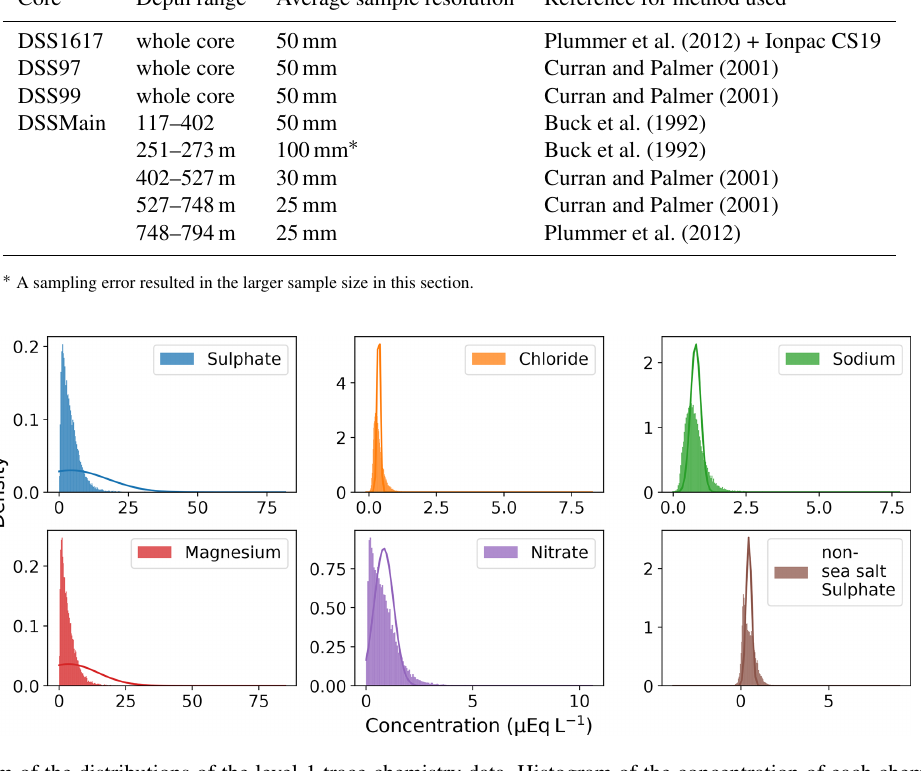
Figure 4. Histogram of the distributions of the level-1 trace chemistry data. Histogram of the concentration of each chemical species with normal probability distribution function overlaid illustrating the non-Gaussian distribution of several of the analytes.